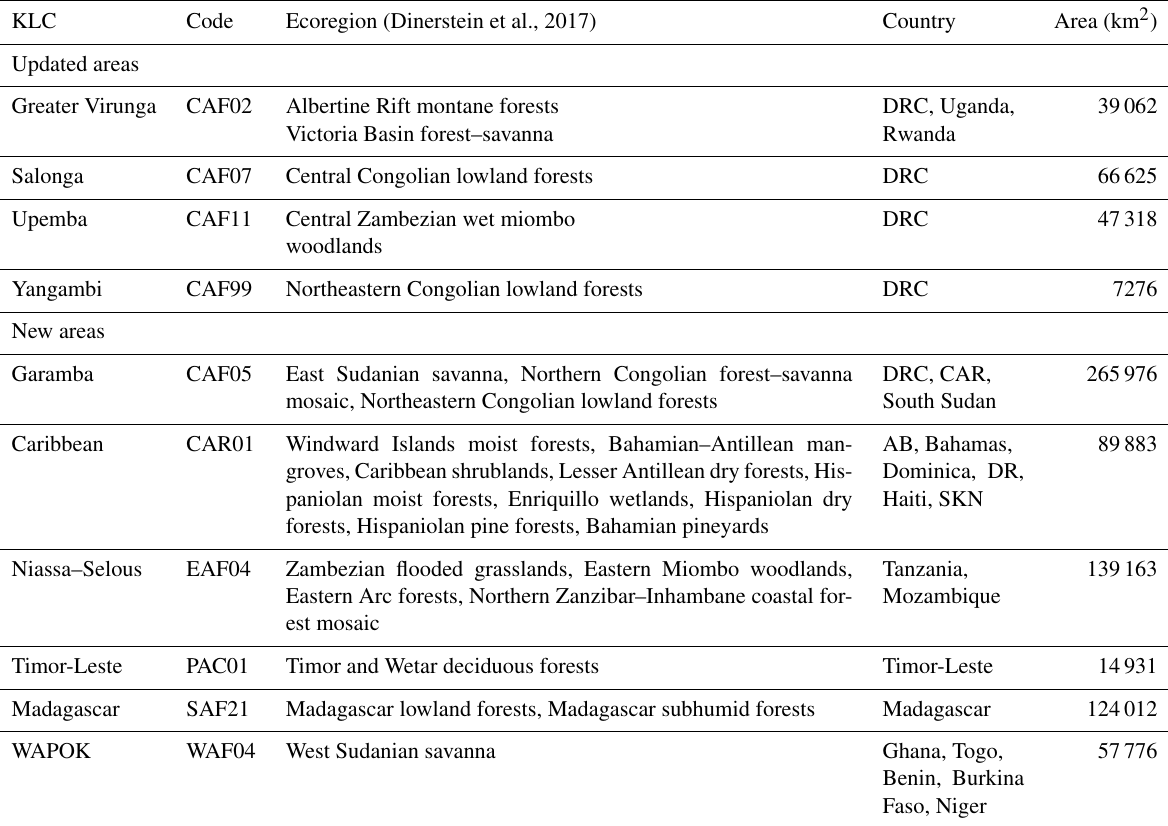
Table 1. Mapped key landscapes for conservation within Phase 2.